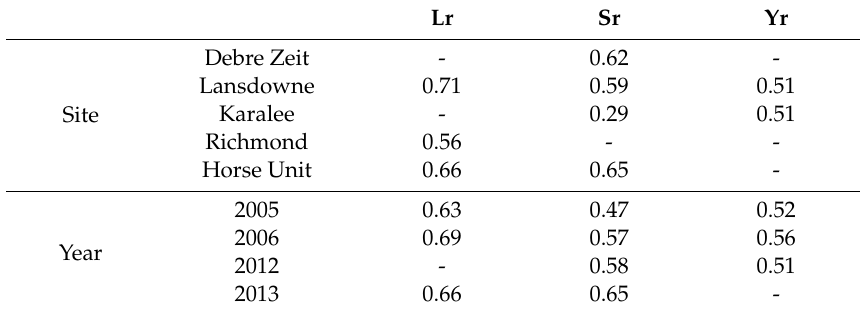
Table 5. Prediction accuracy for adult plant resistance in site-out and year-out validation